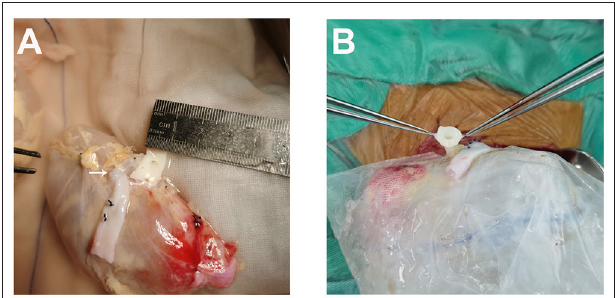
FIGURE 1 | A careful back-table preparation of the kidney. (A) The short right renal vein was extended by reconstruction using the vena cava (white arrow). (B) Tailored aortic